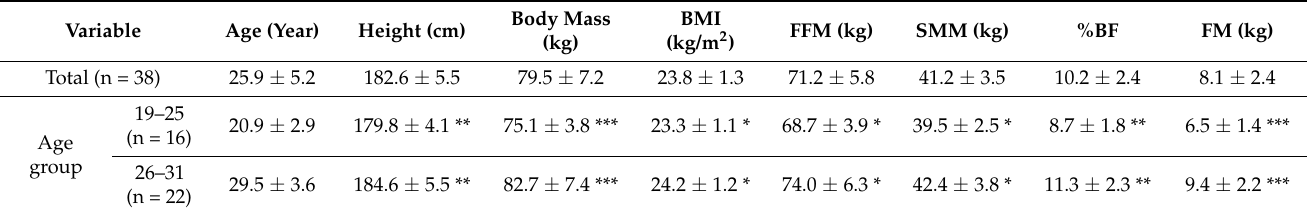
Table 1. Physical characteristics and variables of body composition.